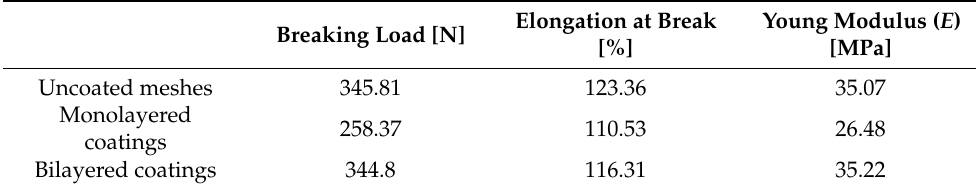
Figure 3. Stress-strain plots of the uniaxial tensile test. Stress vs. displacement curves for uncoated polypropylene (PP) surgical mesh, PP mesh with monolayered fibrin coating, and PP mesh with bilayered fibrin coating are shown. Monolayered and bilayered fibrin coatings were performed with 5 mg/mL fibrinogen and 5.5 IU/mL thrombin solutions in PBS. Table 1. Uniaxial tensile test results of uncoated and fibrin-coated polypropylene surgical mesh. Monolayered and bilayered fibrin coatings were performed with 5 mg/mL fibrinogen and 5.5 IU/mL thrombin solutions in PBS. For each condition, breaking load, elongation at break, and Young modulus were calculated following mechanical